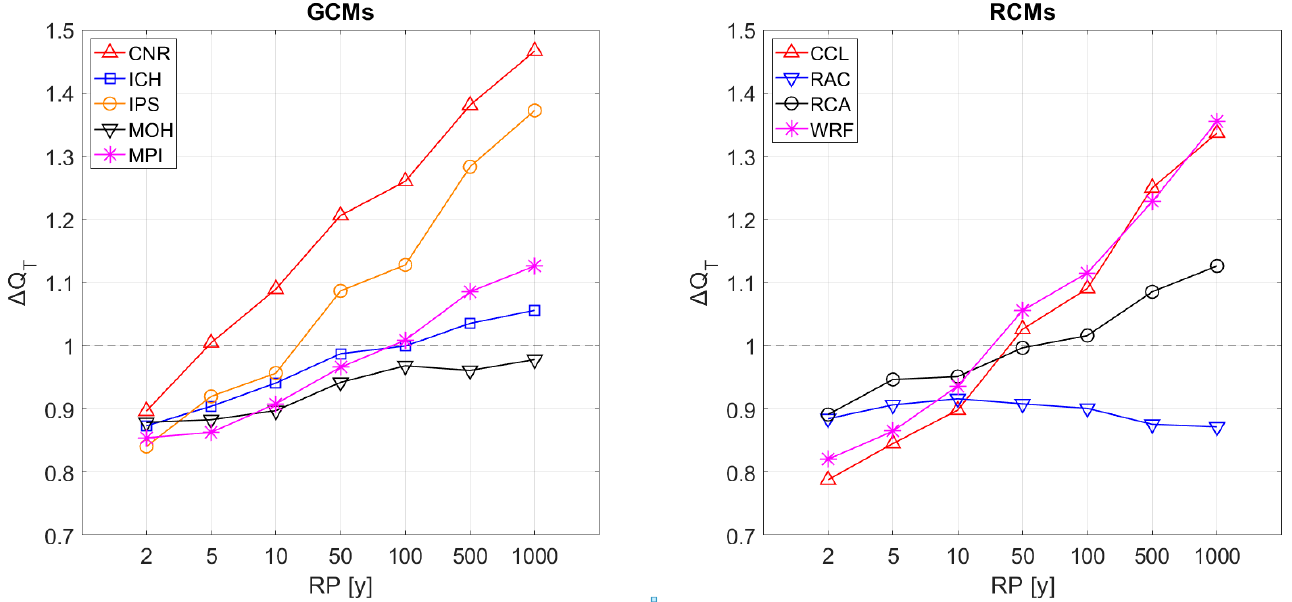
Figure 10. Median values of Δ Q T for the three periods in the future and two RCPs. The results are shown for each return period grouped by global climate models (GCMs) ( left ) and regional climate models (RCMs) ( right ).